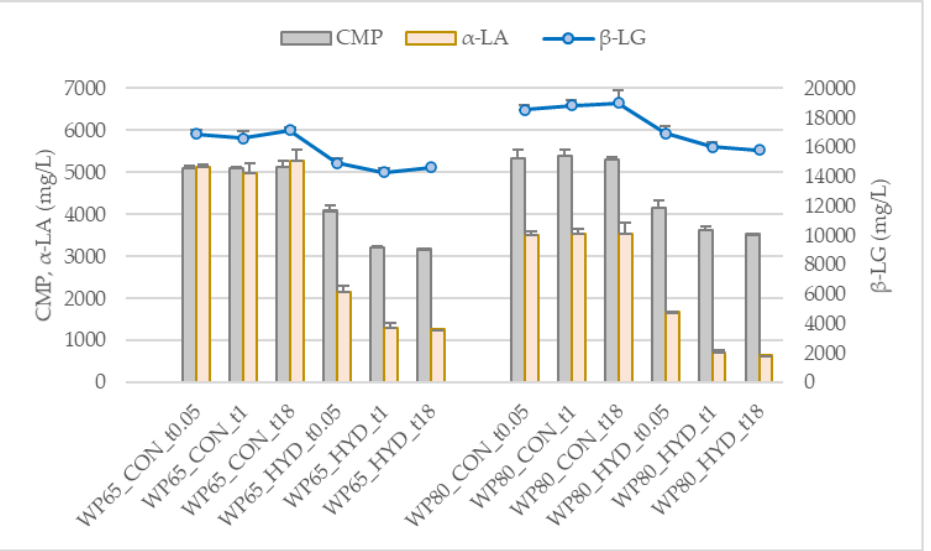
Figure 2. Concentration of the major intact whey proteins in the tryptic hydrolysates of 5% ( w / w ) solutions of WPC powders of sheep/goat origin manufactured from Feta cheese whey in comparison to non-treated control counterparts. Abbreviations are explained in Table 1 and Section 2.2.1. Means and standard deviations of three experiments.